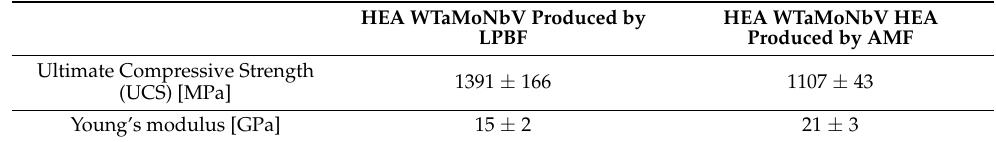
Figure 10. Fractography analysis of HEA WTaMoNbV produced by AMF process, showing trans- granular fracture. 3.5. Environmental Behavior Assessment The environmental behavior of HEA WTaMoNbV obtained by the LPBF process ver- sus that of its counterpart AMF alloy in terms of potentiodynamic polarization analysis is shown in Figure 11, along with the derived electrochemical parameters introduced in Table 11. This indicates that both alloys showed excellent corrosion resistance with a typical ac- tive–passive transition mode [45,46]. In addition, due to the relatively increased roughness of the LPBF alloy, its passivation stability manifested by current density fluctuations was reduced. Regarding the passivation current, although the counterpart AMF alloy showed relatively reduced current density, the break potential of the LPBF alloy that signified the transition to the transpassive state and breakdown of the passive film [47] was higher. This basically means that although the passivation of the AMF alloy is easier to obtain, its stabil- ity is reduced. As a result, the localized corrosion attack of the LPBF alloy in terms of pit dimensions was reduced compared to the AMF alloy, as shown in Figure 12.